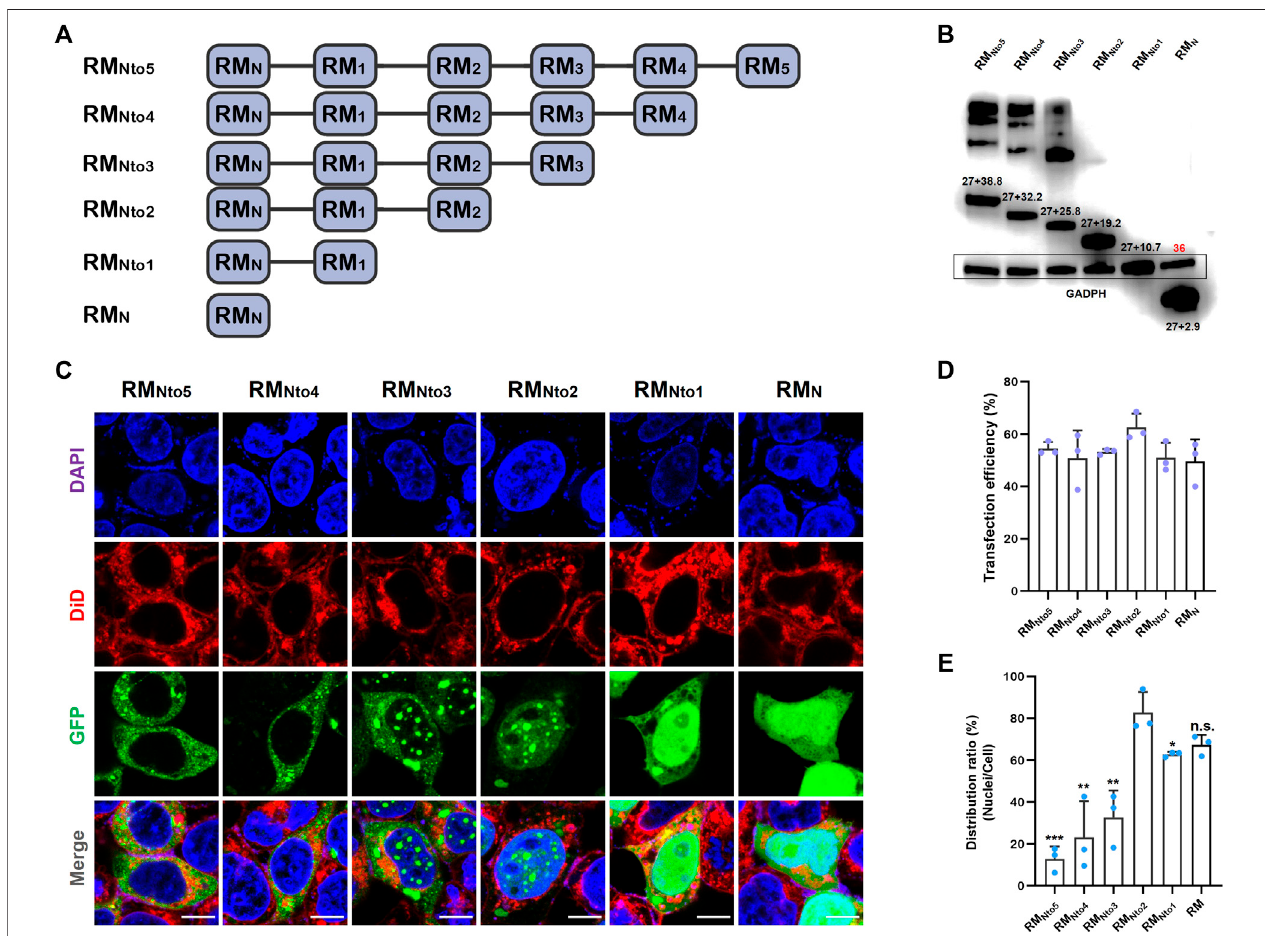
FIGURE 2 | Expression of RfA1 variants in the HEK293T cells. (A) Schematics of RfA1 truncated variants. (B) Expression of RfA1 variants validated by Western blotting and indicated by anti-GFP antibodies. The molecular weight of EGFP is 27 kDa and GADPH is 36 kDa. (C) Cyto-/nucleo-localization preferences of truncated RfA1derivatives.NucleiandmembranearestainedwithDAPI(blue)andDiD(red),RfA1-derivedpeptidesareindicatedbytandemEGFP(green),scalebars=10 μ M. (D) Cell number statistics and quanti fi cation of transfection ef fi ciencies of four re fl ectins. (E) Distribution ratio statistics of fl uorescent intensity in transfected cells and their nuclei. Data are presented as mean values ± SD, for n = 3 independent experiments. p -values (from a two-sided unpaired t test): p , p < 0.05; pp , p < 0.01; ppp , p < 0.001; All groups are compared to RM Nto2